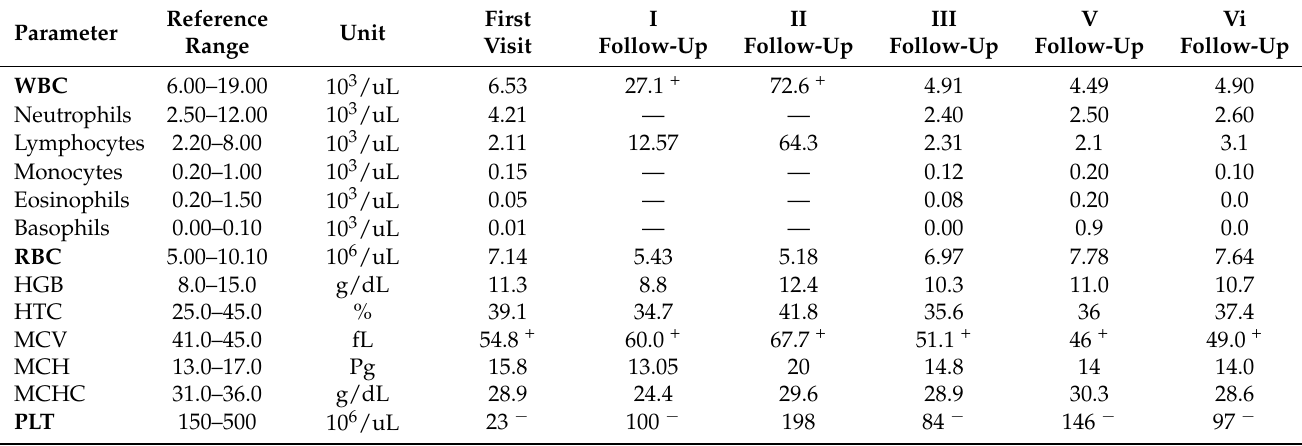
Table 1. Cell blood count analyses, including red blood cells (RBC), haemoglobin (HGB), haematocrit (HCT), Mean Corpuscular Volume (MCV), Mean Corpuscular Hemoglobin (MCH), Mean Corpuscolar Hemoglobin Concentration (MCHC), white blood cells (WBC), and platelets (PLT) performed in a cat affected by Leishmania infantum and treated with allopurinol 10 mg/kg PO q 12 h at different time points; + / − , increasing and decreasing